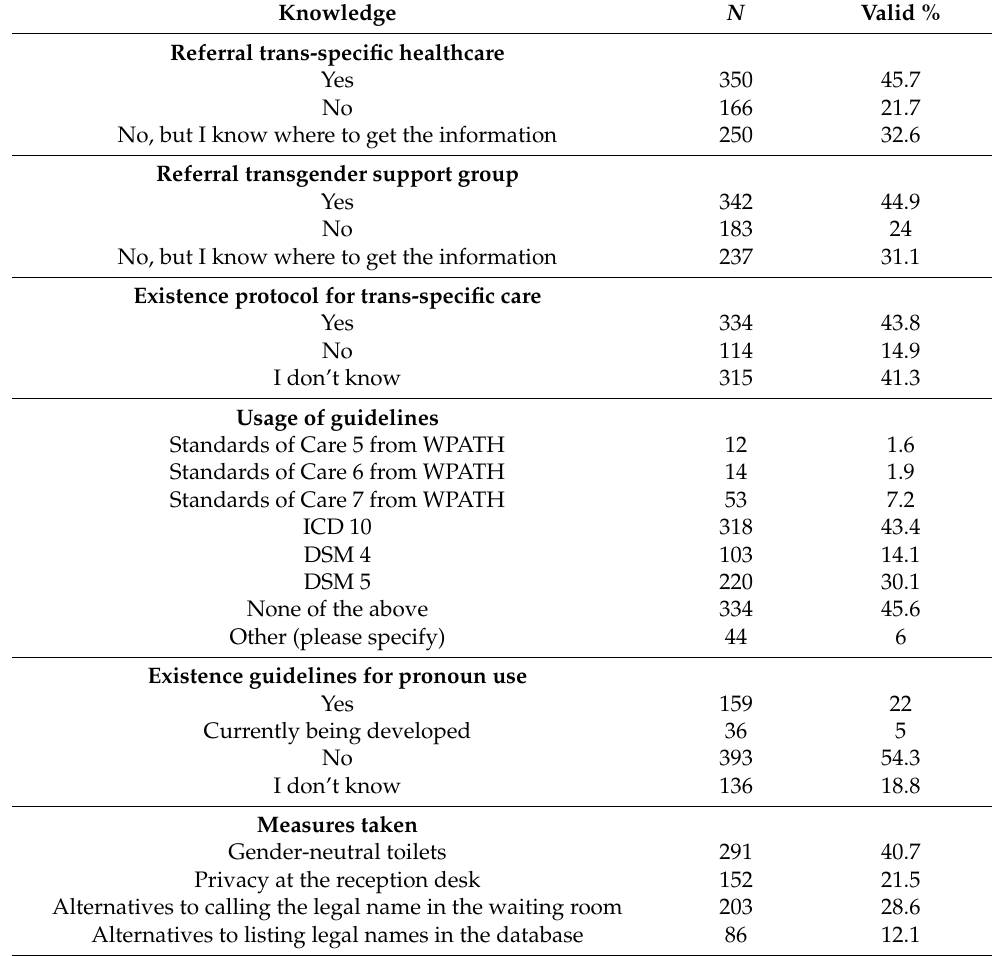
Table 4. Knowledge of HCP N